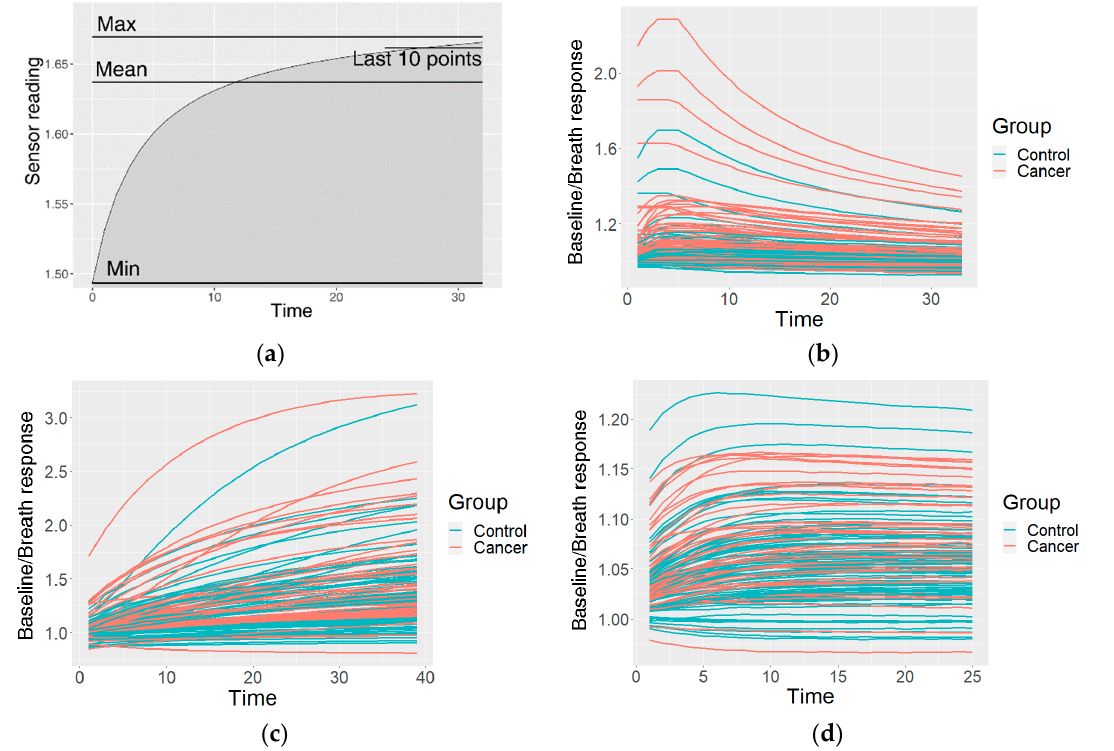
Figure 3. An example of the data after the preprocessing: ( a ) common features describing the curve; ( b ) curves of a GNP sensor; ( c ) curves of an analogue MOX sensor; ( d ) curves of a digital MOX sensor.